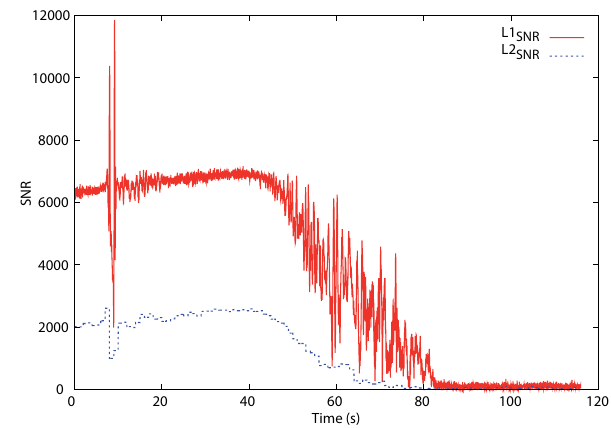
Fig. 1. Signal to Noise Ratio (SNR) on the L1 and L2 channels. SNR are given in arbitrary receiver units. After about 80s the power is not evidently above the noise